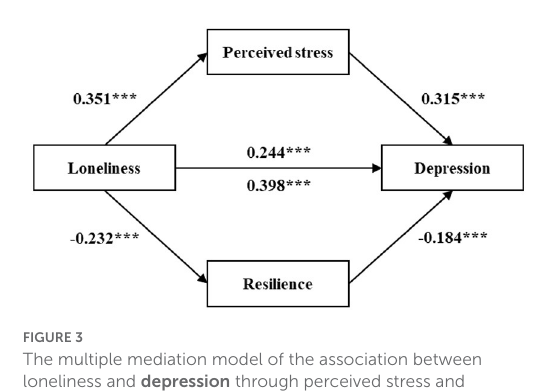
FIGURE3 The multiple mediation model of the association between loneliness and depression through perceived stress and resilience. *** p < 0.001 (two-tailed). All values have been